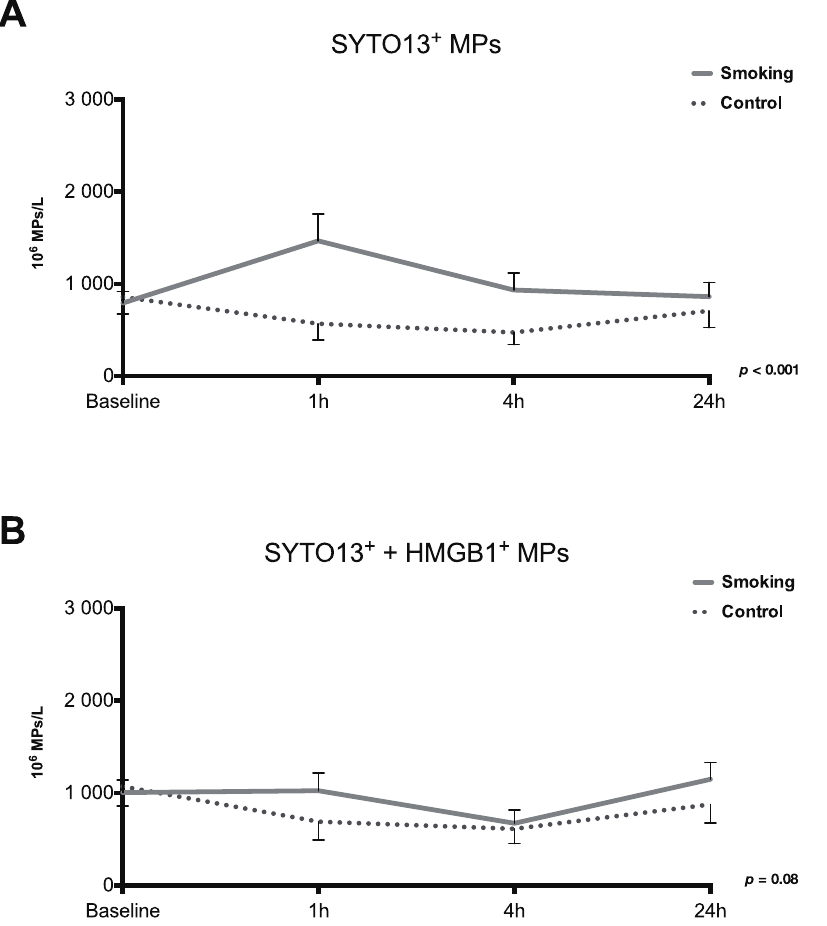
Figure 4. Nuclear molecule content of microparticles after smoking and control. Microparticles were measured by flow cytometry and gated according to size and SYTO 13 binding alone (A) or together with HMGB1 exposure (B). Data is presented as mean 6 SE. Statistical differences (two-factor ANOVA) are indicated for each panel.